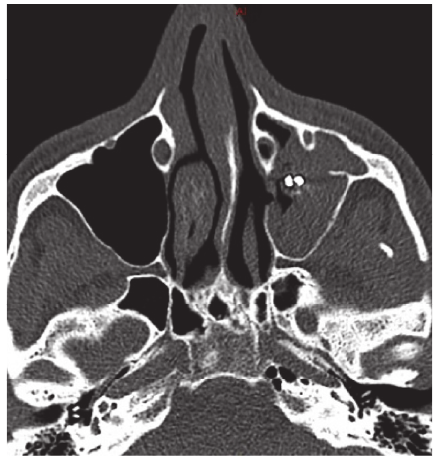
Figure 1: CT facial scan that shows the aspect of an endosinusal foreign